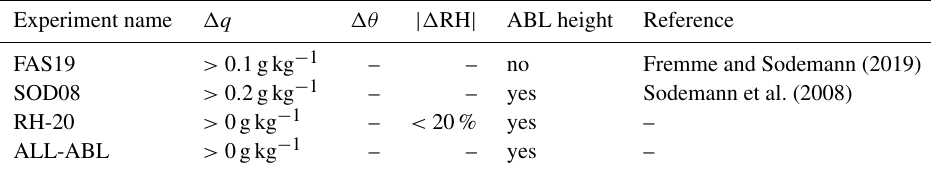
Table 1. Overview of detection criteria for evaporation.